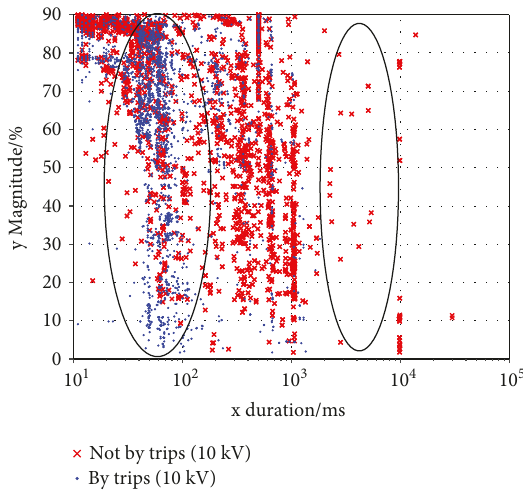
Figure 11: Scatter plot of voltage dips and breakdowns against duration under 10kV voltage level (half logarithmic